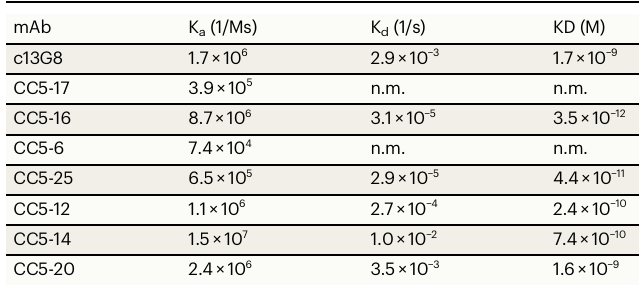
Table 1 | SPR binding characterization of anti-GP38 mAbs against Hoti GP38